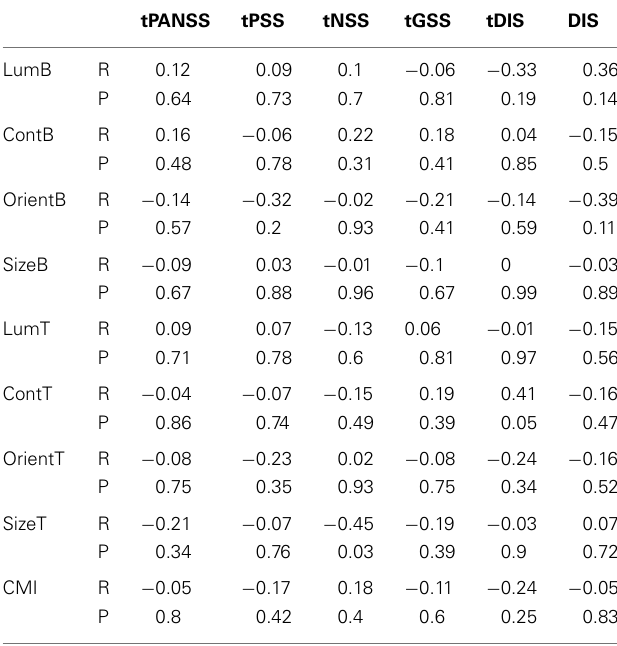
Table 6 | Correlations between the behavioral measures (biases and thresholds) and PANSS scores (patient data